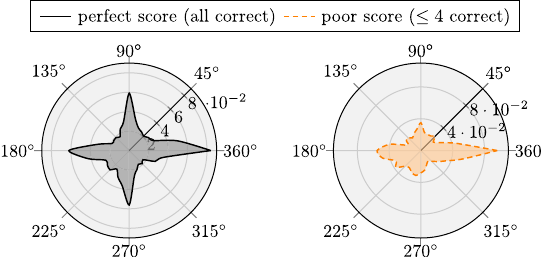
FIG. 8. Polar distributions of saccadic angles for experts and novice students including data from all curl